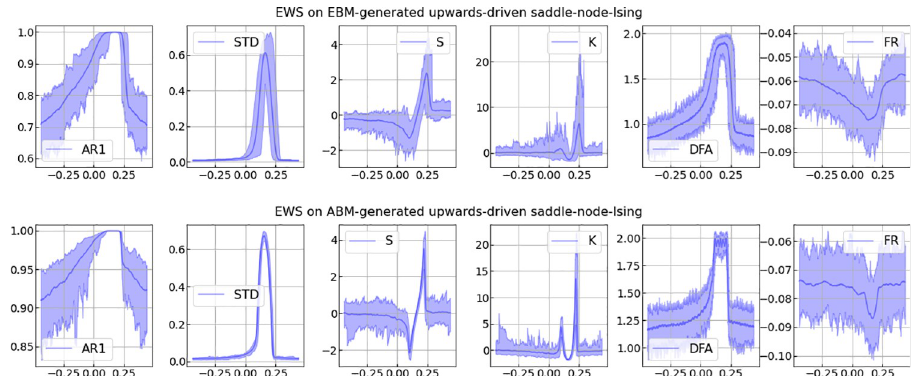
saddle-node transition. Data generated with the EBM- and ABM-models as described in the section: Ising model. Considered EWS-indicators are auto-correlation with lag-1 (AR1), standard deviation (STD), skewness (S), kurtosis (K), detrended fluctuation analysis (DFA) and spectral reddening (FR).